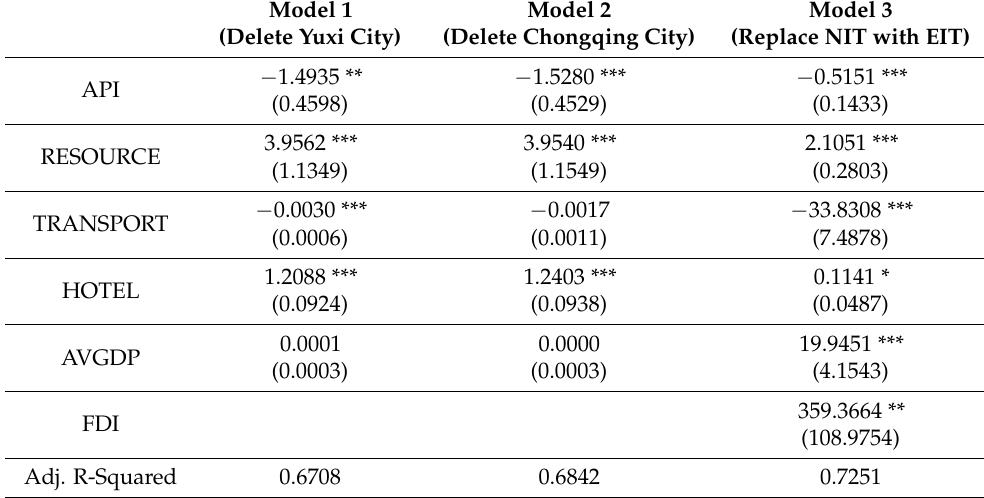
Table 3. A robust analysis of the impact of air pollution on inbound tourism development from 2002 to